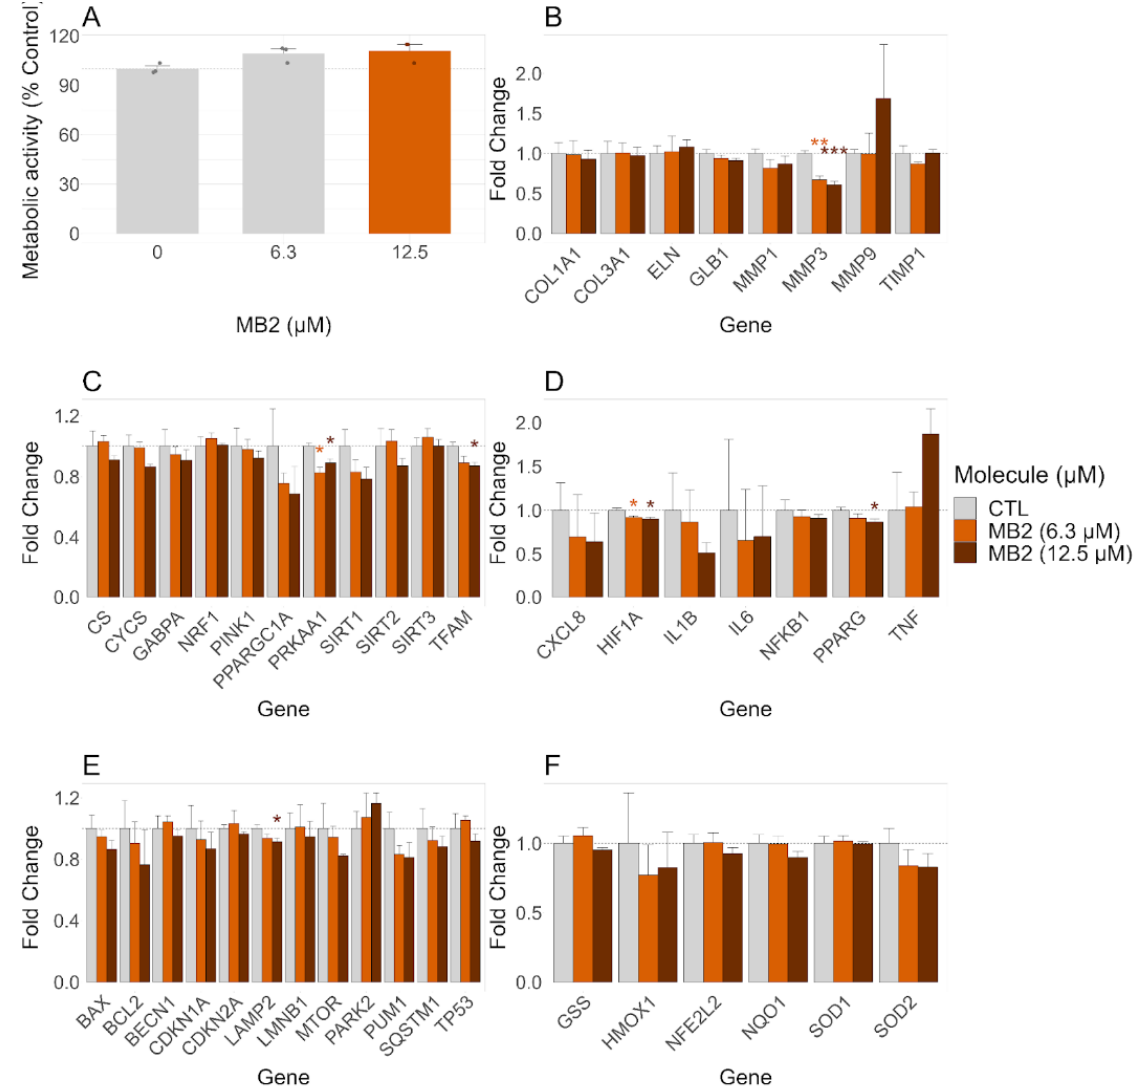
Figure 7. Effect of MB2 on the metabolic activity ( A ) and on the transcripts relevant to mitochondrial biogenesis, for the modulation of mitochondrial metabolism, and measurement of anti-inflammatory mediators ( B – F ) in the 3D EpidermFT skin model.